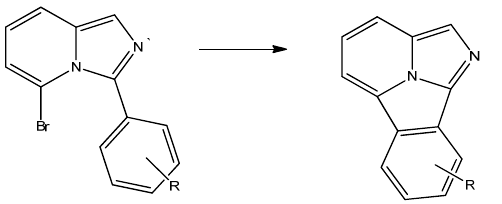
A similar process was employed to obtain highly fluorescent benzo derivatives of azacyclazine starting from Br-substituted 3-aryl imidazopyridines 81 , Scheme 45, Table 20 [8,101].